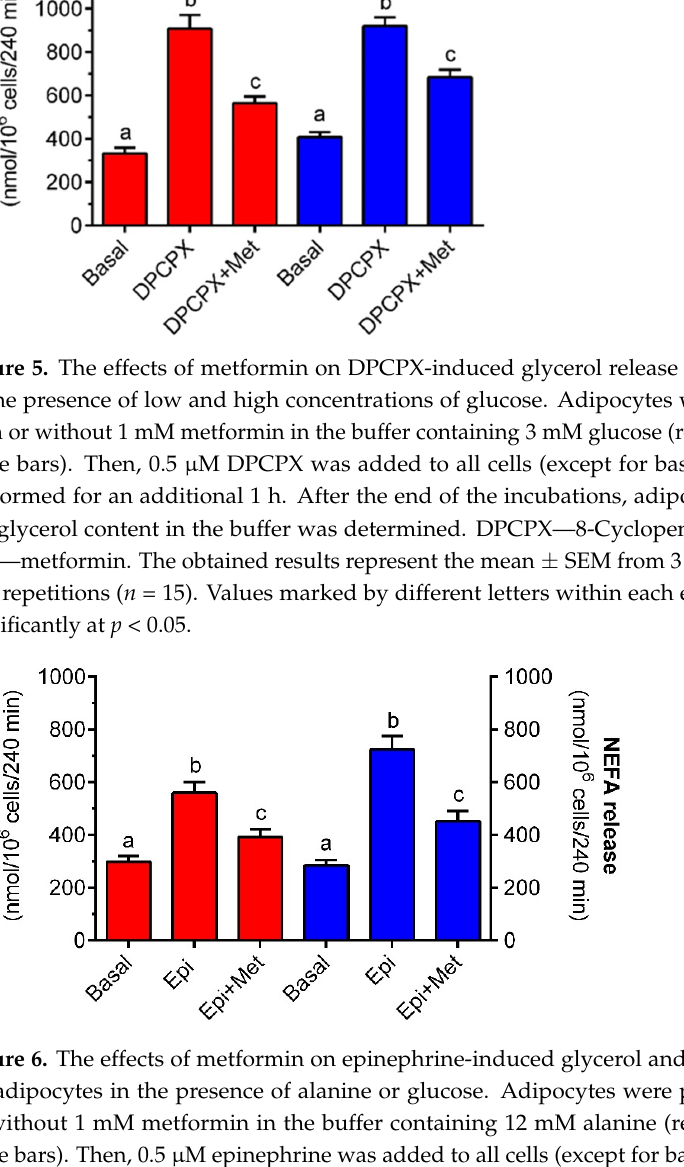
Figure 6. The effects of metformin on epinephrine-induced glycerol and NEFA release in isolated rat adipocytes in the presence of alanine or glucose. Adipocytes were preincubated for 3 h with or without 1 mM metformin in the buffer containing 12 mM alanine (red bars) or 3 mM glucose (blue bars). Then, 0.5 µM epinephrine was added to all cells (except for basal) and incubations were performed for an additional 1 h. After the end of the incubations, adipocytes were removed and the glycerol or NEFA content in the buffer was determined. Epi—epinephrine, Met—metformin, NEFA—non-esterified fatty acid. The obtained results represent the mean ± SEM from 3 independent experiments in 5 repetitions ( n = 15). Values marked by different letters within each experimental group differ significantly at p < 0.05.